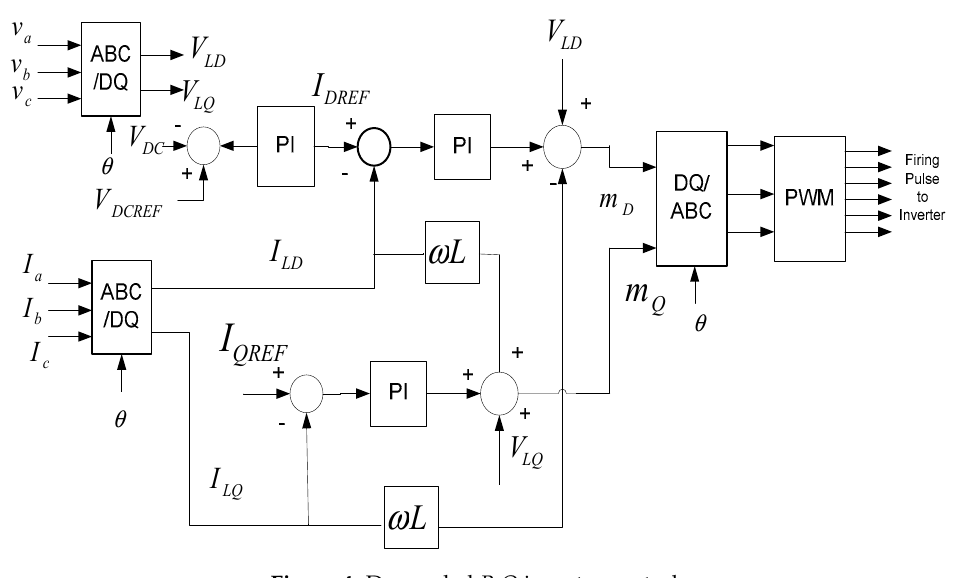
Figure 4. Decoupled P - Q inverter control.